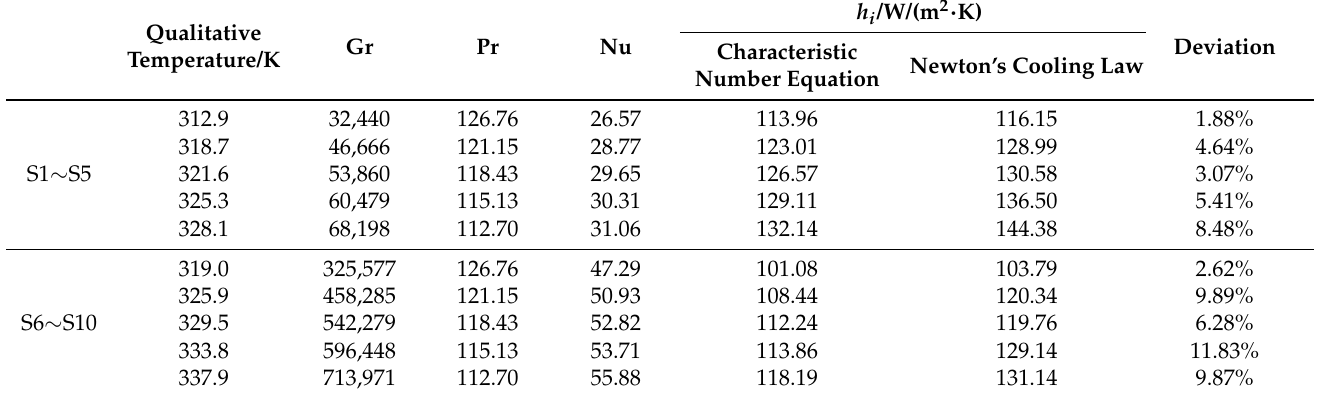
Table 2. Natural convective heat transfer coefficients under different